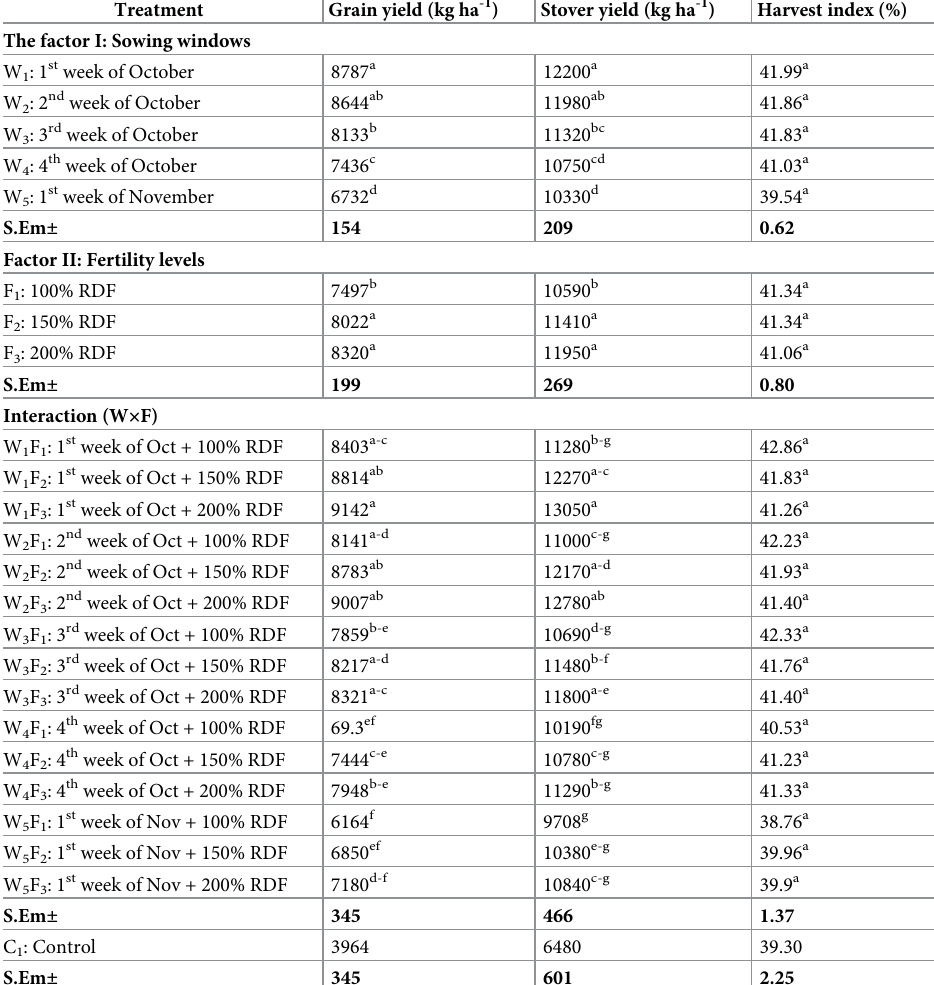
Table 3. Grain yield, stover yield, and harvest index of winter maize as influenced by sowing windows and fertility levels. Treatment Grain yield (kg ha -1 ) Stover yield (kg ha -1 ) Harvest index